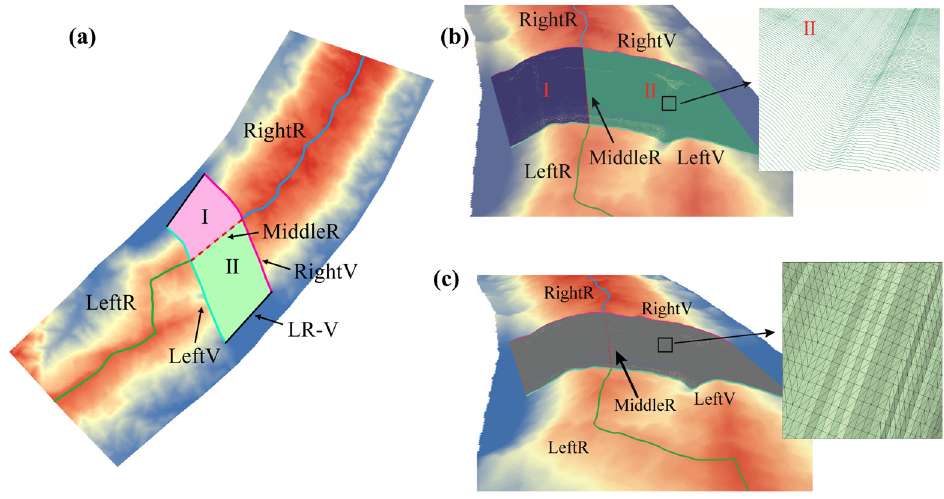
Figure 13. ( a ) Schematic diagram of the C4 region division result. Ⅰ and Ⅱ are three-edge types; ( b ) the transition curves; and ( c ) vector mesh surface.